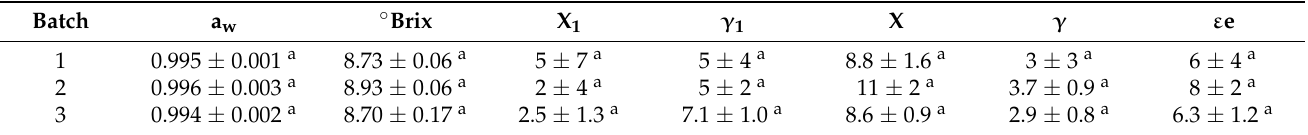
Table 1. Vacuum impregnation parameters of lulo fruit slices (mean ± standard